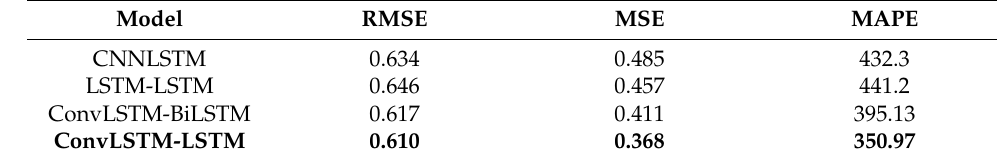
Table 6. Comparison of the evaluation metrics on the univariate NYISO electricity dataset.